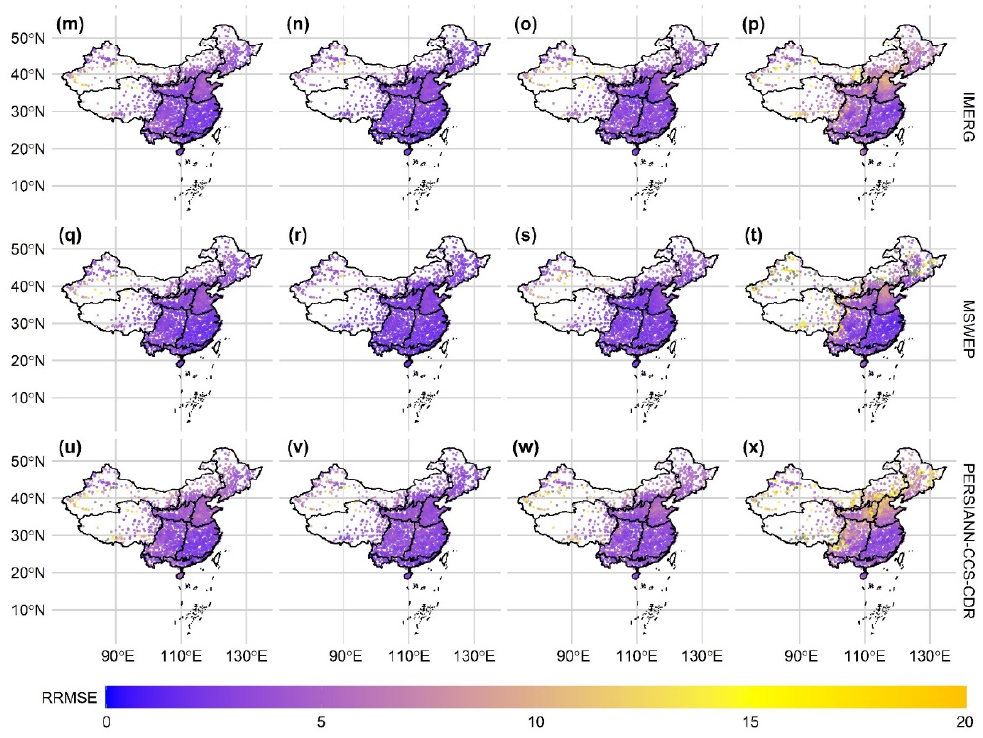
Figure 10. Distribution of RRMSE values of six products for different seasons between 2015 and 2019. From top to bottom: ( a – d ) CHIRPS, ( e – h ) ERA5-Land, ( i – l ) GSMaP, ( m – p ) IMERG, ( q – t ) MSWEP and ( u – x ) PERSIANN-CCS-CDR.